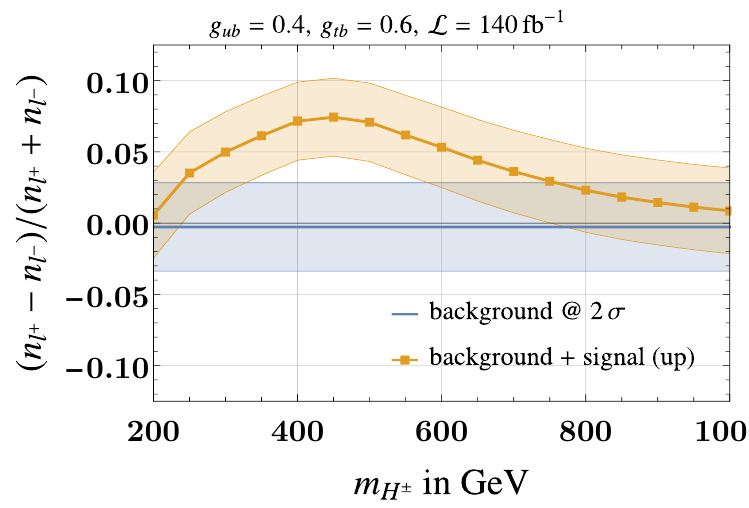
Figure 13 . Charge asymmetry comparison between the signal (charged Higgs production through the ub coupling) and the SM background, as a function of the charged Higgs mass, for the final state selection bbb‘ explained in the text. We include statistical and systematic uncertainties in the SM estimate of the asymmetry, see text for